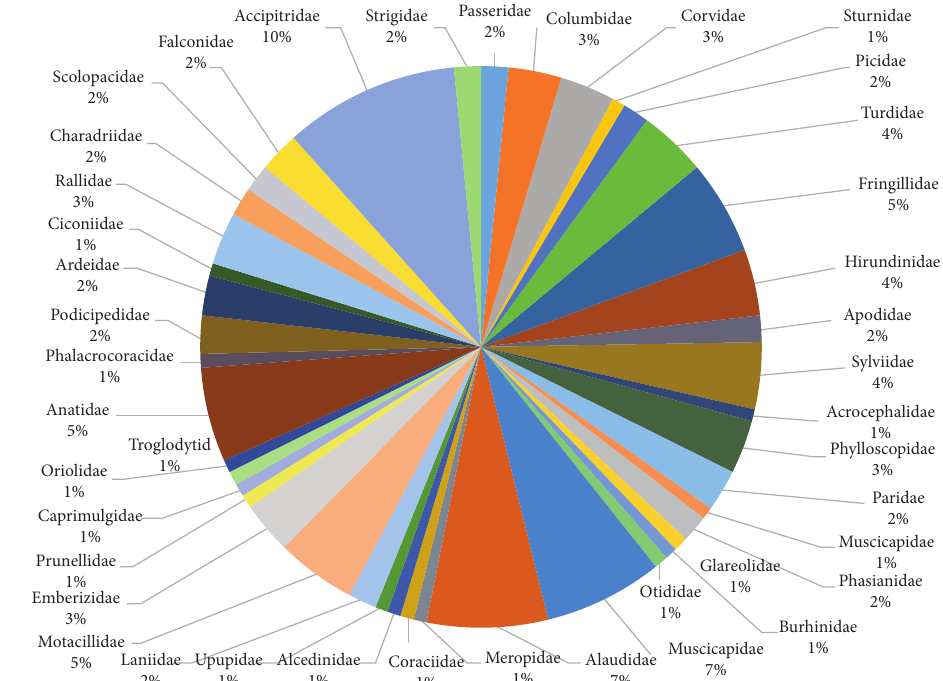
Figure 2: Species richness and percentage of avian families recorded in Midelt